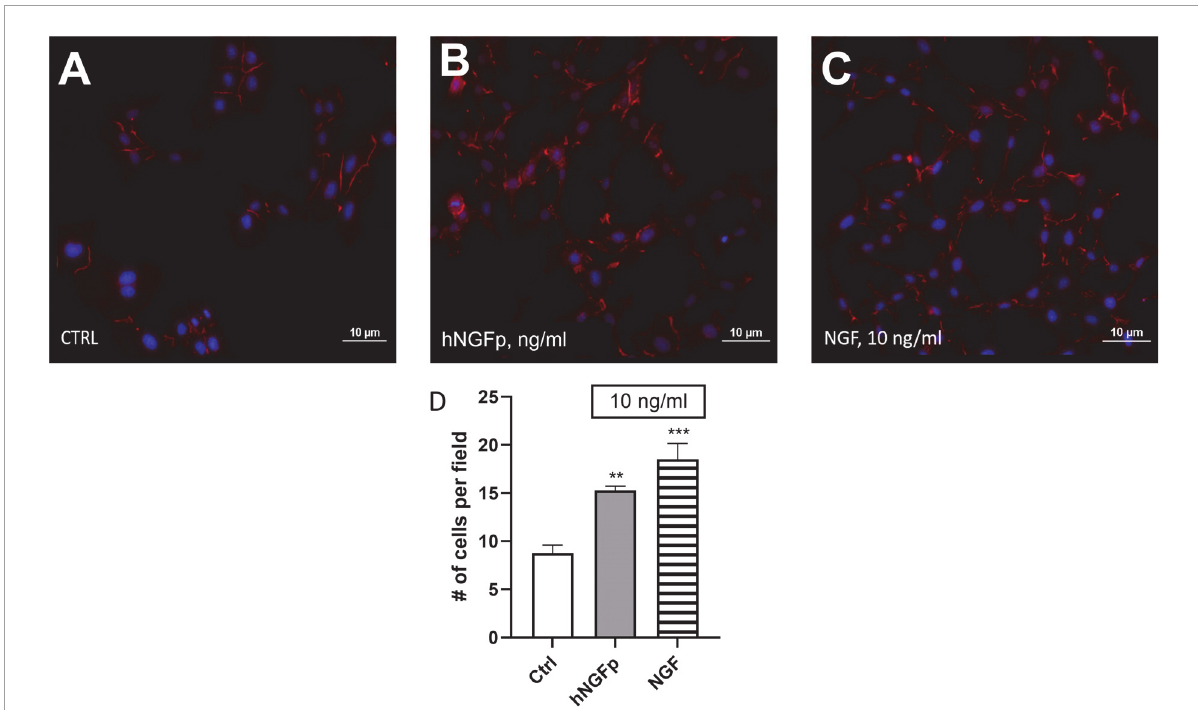
FIGURE3 Evaluation of CHME-5 morphology after nerve growth factor (NGF) treatments. The cells were analyzed under basal condition (A) , after 24 h 10 ng/ml of painless human Nerve Growth Factor (hNGFp) treatment (B) and after 24 h 10 ng/ml wild type NGF treatment (C) : Magnitude 20X. Quantification of cell number elicited by NGF treatment (D) . One-way ANOVA analysis followed by Bonferroni’s post-test was carried out F (2, 9) = 19.94; P = 0.0005. The experiment was repeated three times with similar results. ** p < 0.01 and *** p <